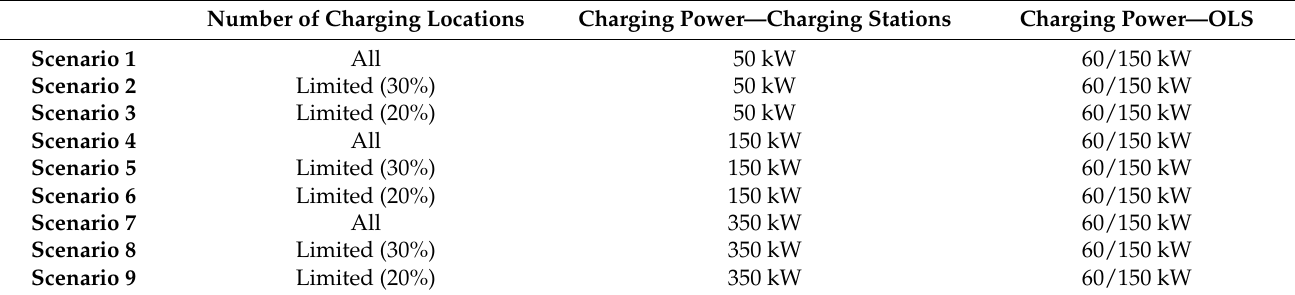
Table 2. Scenarios of distribution and charging capacity of charging stations (own